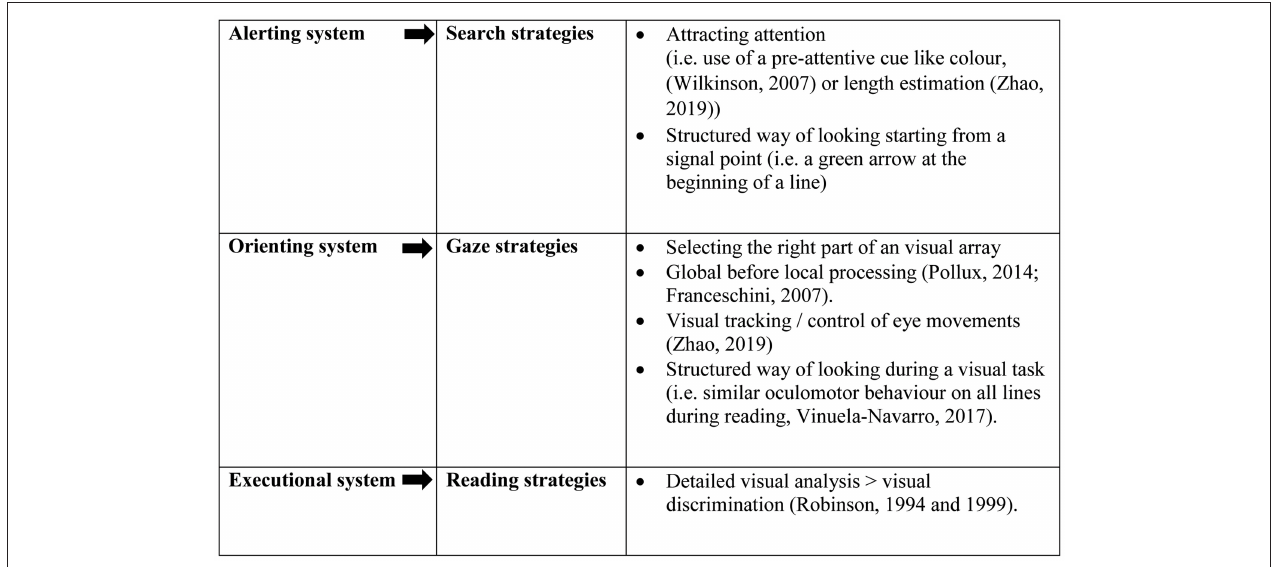
FIGURE 2 | Viewing strategies in relation to Posner’s attention